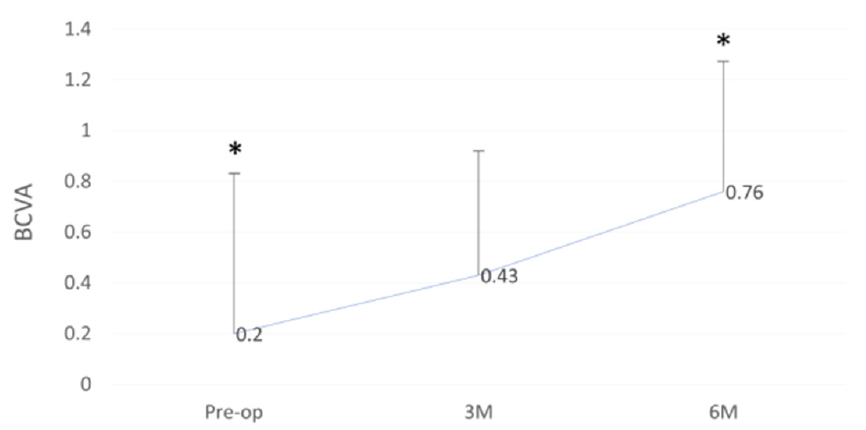
Figure 4. Best-corrected visual acuity (BCVA) outcome before and after DMEK “Wave Maneuver” operation. Graph displaying the BCVA before (Pre-op) and Post-op at 3 and 6 months after DMEK “Wave Maneuver” operation. BCVA: best corrected visual acuity. M: months. Asterisk represents statistical significance ( p < 0.01) for Pre-op versus 6M.